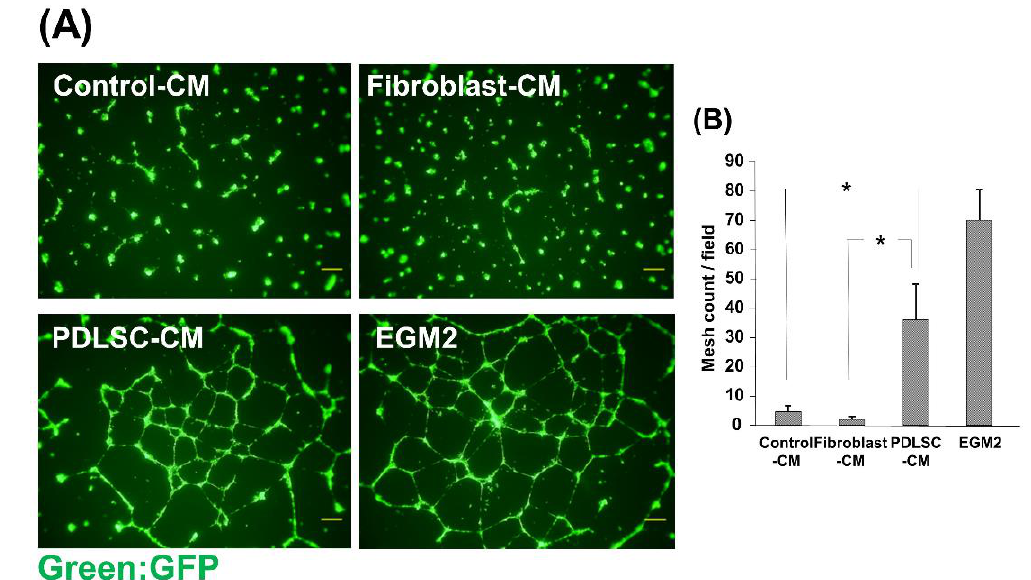
Figure 5. Effect of CM on the network formation of HUVECs. Fluorescence microscopic images of HUVEC networks ( A ). HUVECs-GFP were cultured on Matrigel in the presence of Control-CM, Fibroblast-CM, PDLSC-CM, and EGM2. The number of mesh structures formed by HUVECs was quantified ( B ). HUVECs in PDLSC-CM formed more capillary-like networks than those in Control-CM and Fibroblast-CM. (* p < 0.05) (HUVECs = human umbilical cord vein endothelial cells, CM = conditioned medium, PDLSCs = periodontal ligament stem cells, EGM2 = endothelial cell growth medium 2). Data from an independent experiment performed three times were shown. ( n = 3).